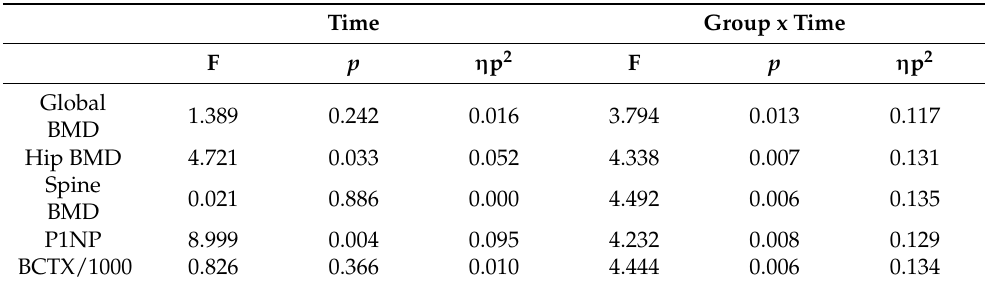
Table 4. Results of the ANOVA on bone